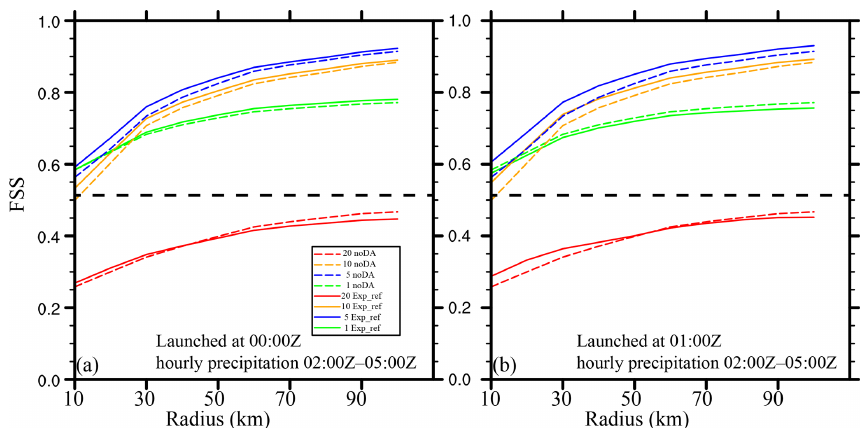
Figure 14. The FSSs of the hourly precipitation forecasts aggregated over the period from 02:00 to 05:00Z as functions of the radius of influence for forecasts launched from the (a) 00:00 and (b) 01:00Z analyses for Exp_ref (solid lines) and noDA (dashed lines). The hourly precipitation thresholds are denoted by green (1mmh − 1 ), blue (5mmh − 1 ), orange (10mmh − 1 ), and red (20mmh − 1 ) lines. The straight dashed line represents the skillful FSS at 1mmh − 1